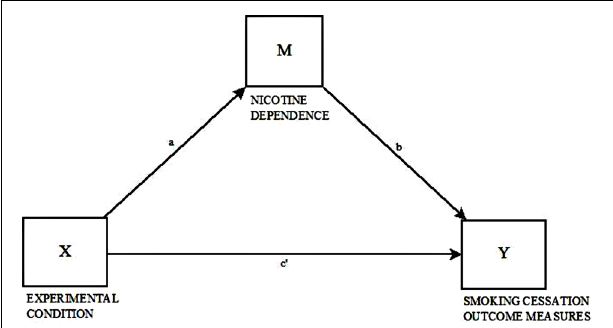
FIGURE 1 | Path diagram of the effect of the intervention on smoking cessation outcome measures at 12-month follow-up (Time 3) via nicotine dependence (ND) (Time 2), after controlling for baseline differences, gender, age, and school. X, Independent variable; Y, Dependent variable; M, Mediator; a, b, c (cid:48) , Regression coefficients. The 95% CIs for indirect effects were obtained by bootstrapping with 5,000